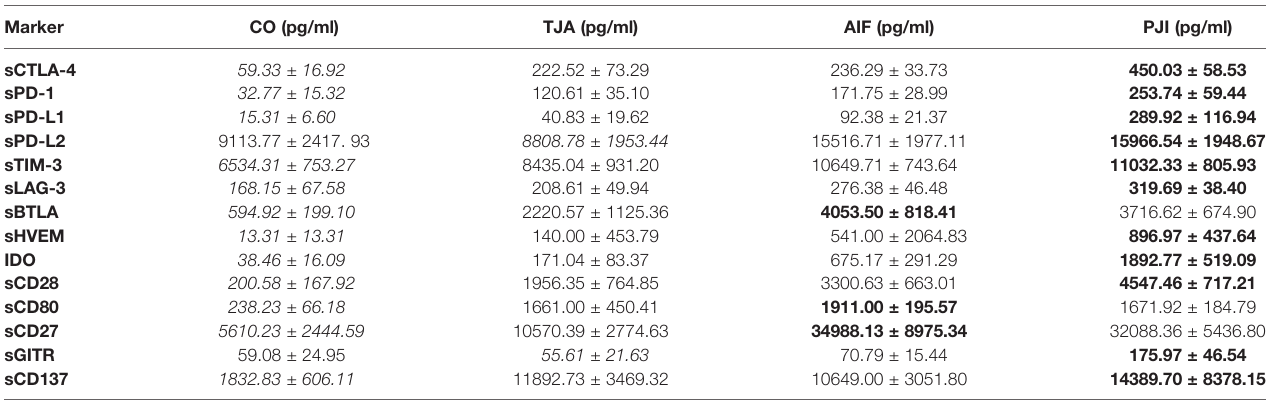
TABLE 2 | Mean concentrations according to bead-based multiplex assays.